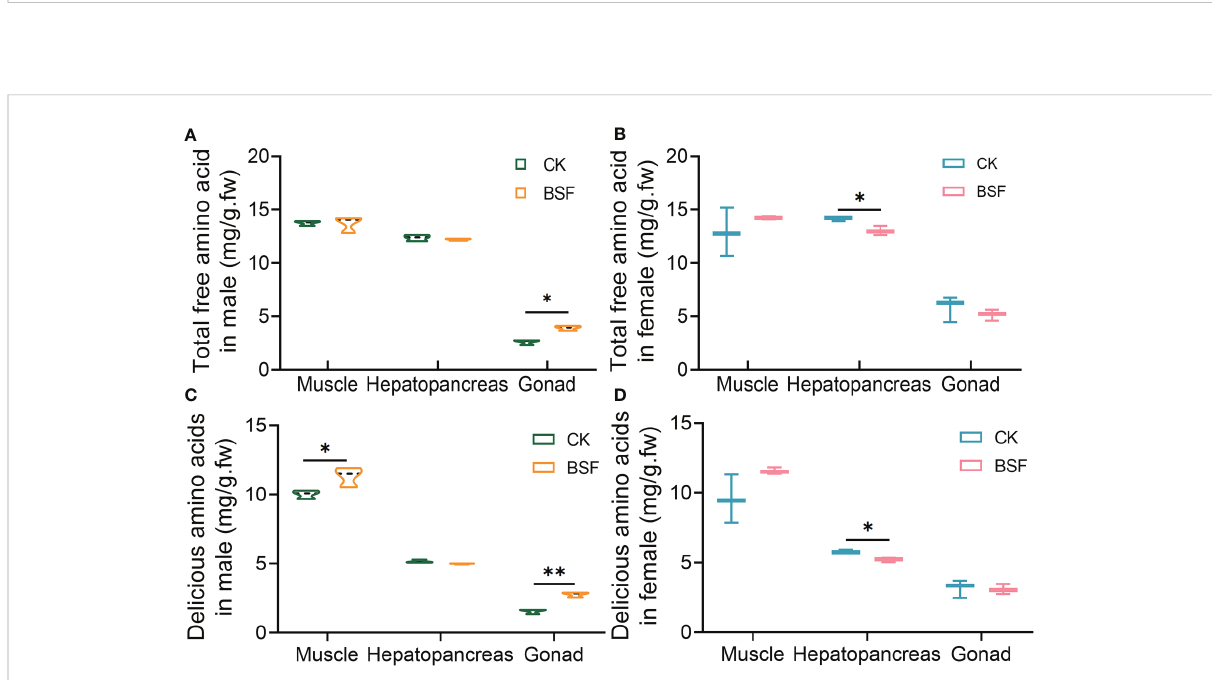
FIGURE 1 Effects of BSFL feeding on total free amino acid and delicious amino acid levels in edible tissues of mitten crabs. Total amino acid contents (A, B) and delicious amino acid contents (C, D) in edible tissues of male and female crabs. CK, control group; BSF, experimental group. * P ≤ 0.05; ** P ≤ 0.01. n =